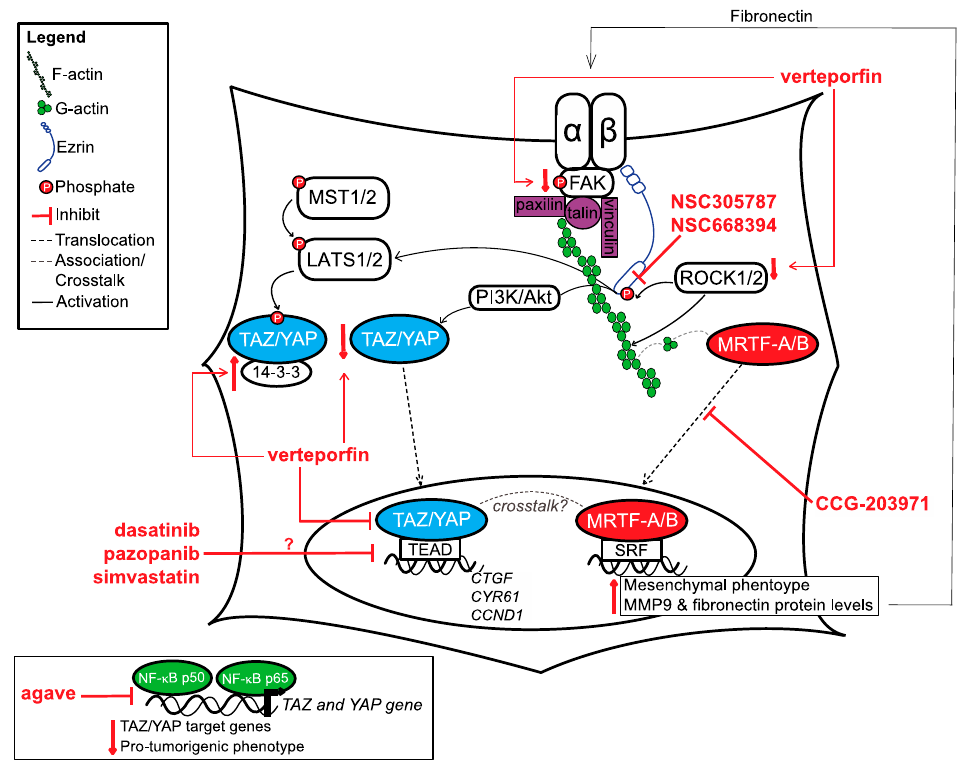
Figure 2. Summary of pathways that OSA cells used to respond to mechanical cues and therapeutic targets discussed in this manuscript. TAZ / YAP, MRTF-A / B and ezrin have all been demonstrated to be important for mechanical signalling in OSA. Upward pointing red arrow indicates increase, downward pointing red arrow indicates decrease.